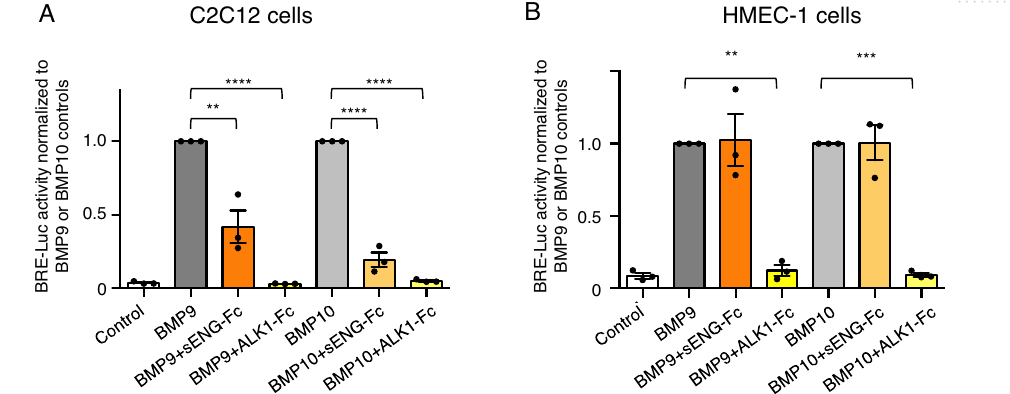
Figure 7. The effect of sENG is context dependent. Parallel luciferase assays were performed using BMP- response element (BRE) transfected non-endothelial cells C2C12 or endothelial cell line HMEC-1, with BMP9 or BMP10 treatment, in the presence or absence of sENG-Fc. ALK1-Fc was used as a positive control. BMP9 or BMP10 (both at 0.2 ng/ml for HMEC-1 cells and 10 ng/ml for C2C12 cells) were incubated with sENG-Fc (2.5 μg/ml) or ALK1-Fc (1 μg/ml) at 37 °C overnight before applying to the cells. Data are Mean ± SEM from three independent experiments. For each experiment, triplicate treatments were performed and data averaged, normalized to BMP9 or BMP10-treated controls, respectively. One way ANOVA analyses were performed in each BMP9 or BMP10 treated groups. ** P < 0.01, *** P < 0.001, **** P <